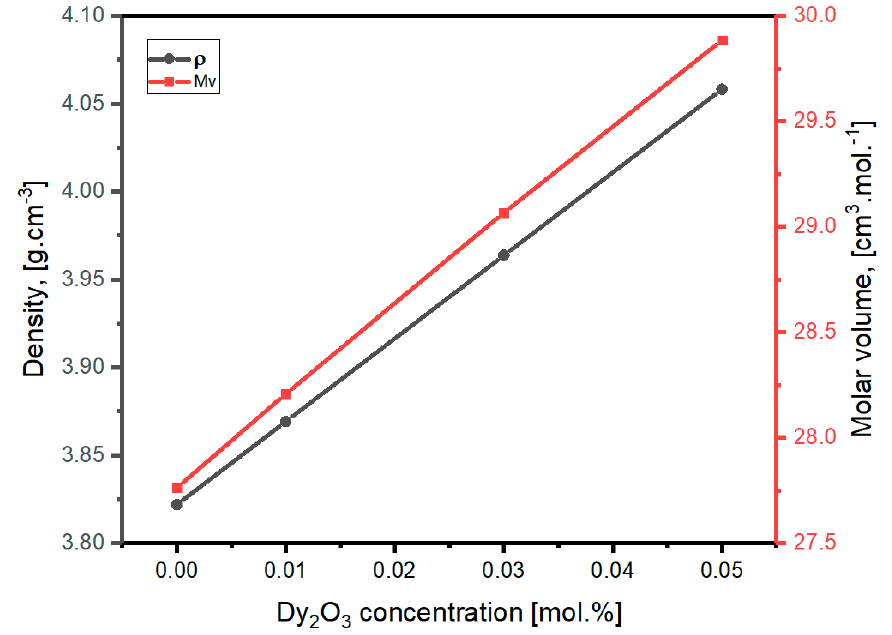
Figure 4. Variation of density and molar volume with the Dy 2 O 3 concentration.